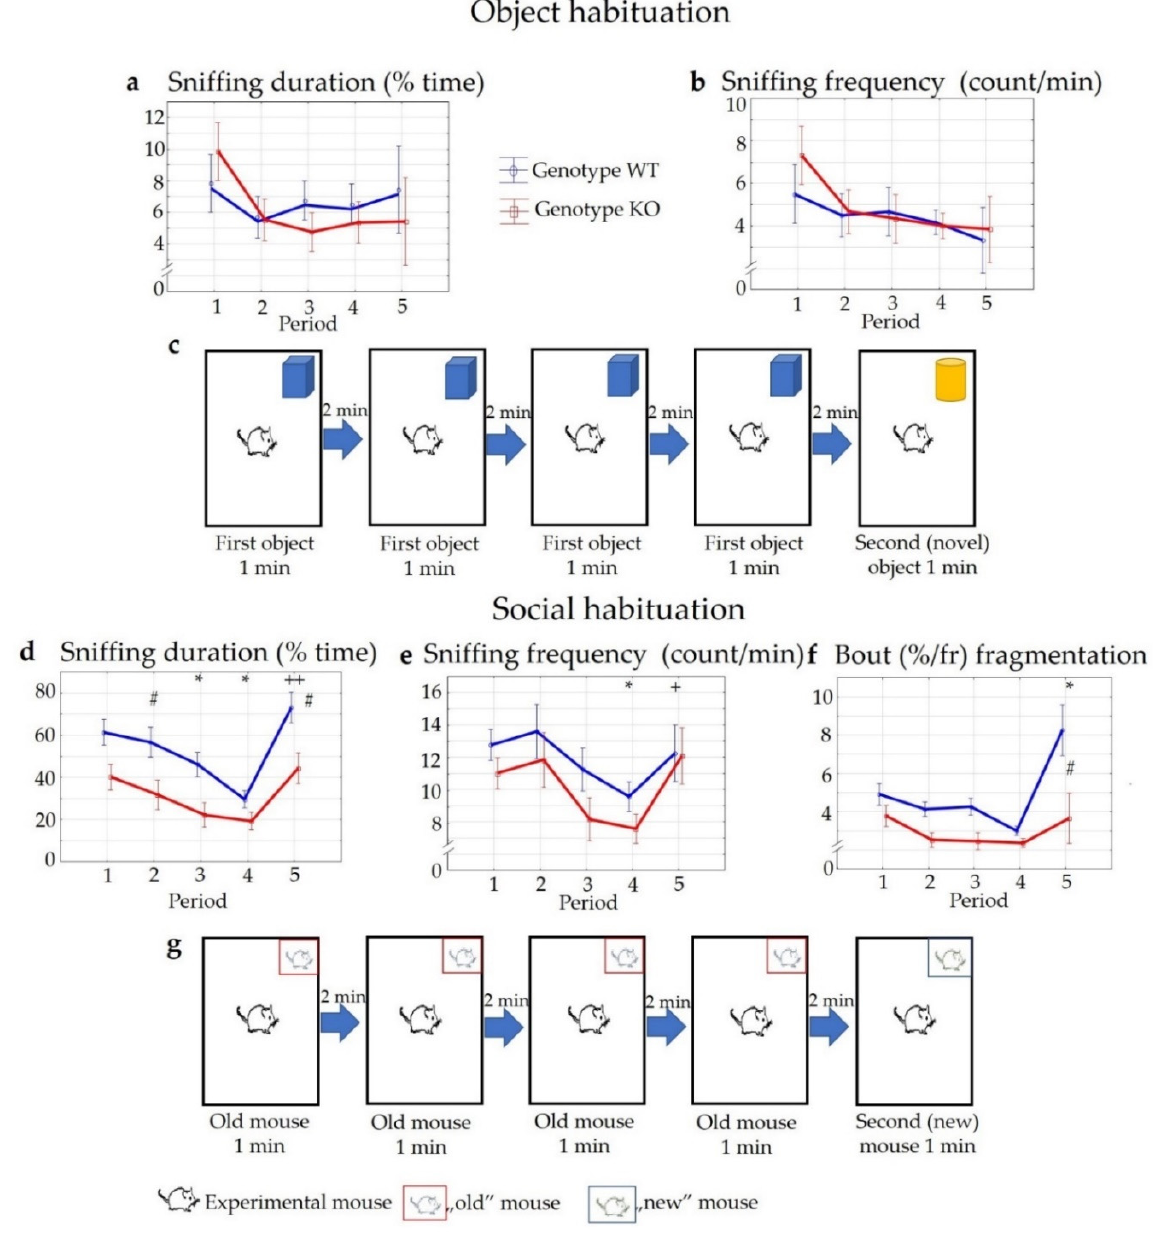
Figure 7. Results of object ( a – c ) and social habituation–dishabituation trials ( d – g ). There was no difference in the duration and frequency of sniffing an object between the genotypes during the object habituation test ( a , b ). During the social habituation trial, a remarkable decrease in the social behaviour was shown using the first stimulus repeatedly in mice of both genotypes. However, after adding a novel stimulus for mice, the social interactions were again increased ( d – f ). The social behaviour of KO mice was lower than WT mice during the whole examination period, with significant differences in the 2nd and 5th part of the trial ( d ). n = 12 in both groups, the symbol # shows a significant difference between KO and WT mice ( p < 0.05); * shows a significant difference between the periods compared to the 1st part of the trial in the same group, in cases with * p < 0.05; + shows a significant difference between the 4th and the 5th part of the trial in the same group, in cases with + p < 0.05 and ++ p < 0.01 .